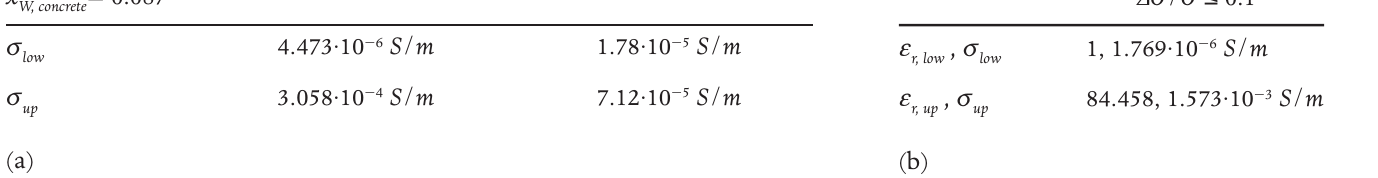
/ f ≤ 0.1 and Dv / v ≤ 0.1, once designed optimally x r r